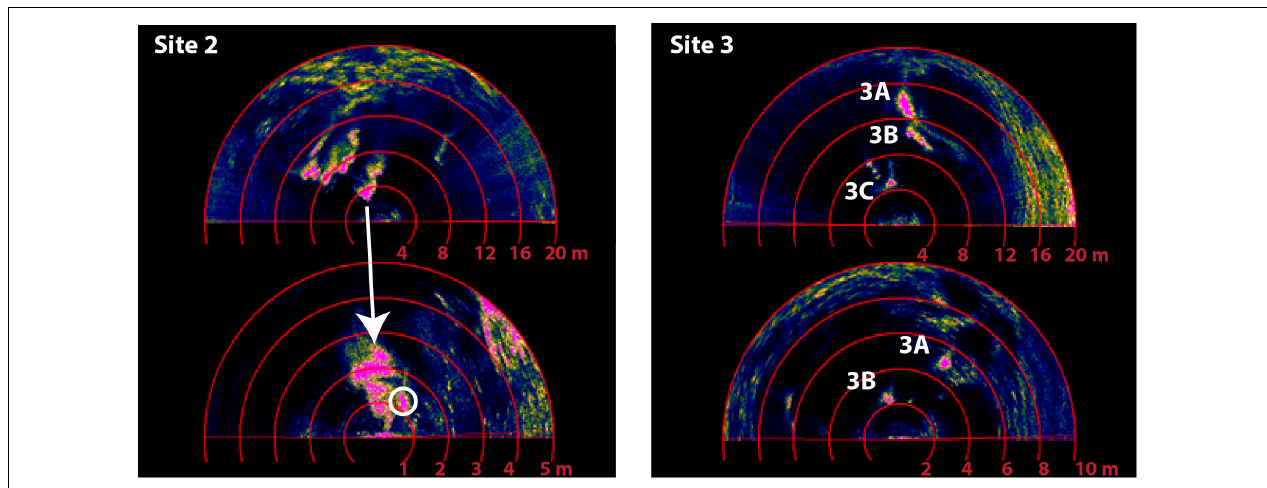
two emission sites differed significantly. Bubbles contained